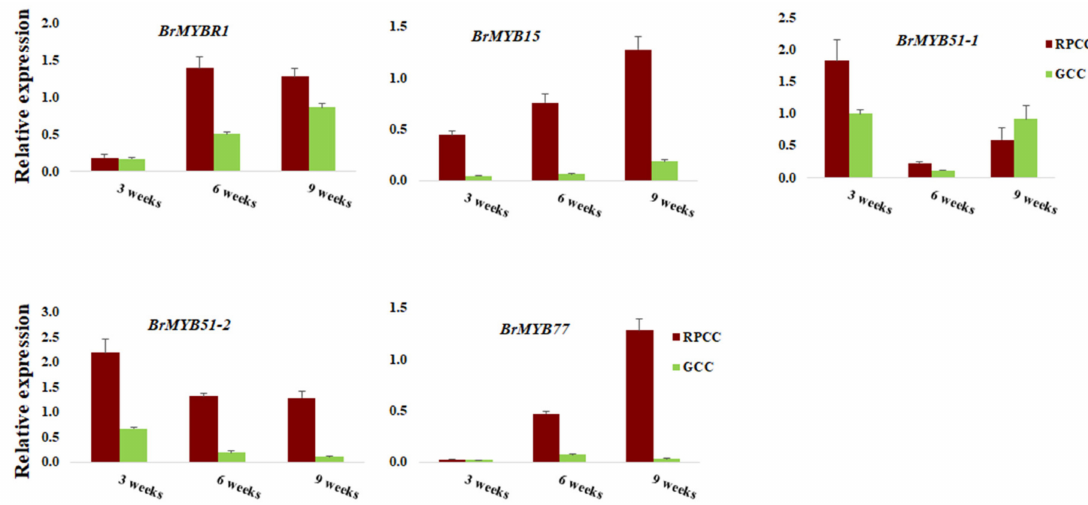
Figure 6. qRT-PCR validation of MYBs with high transcript abundance in transcriptome data. qRT-PCR expression values were normalized against that of Actin . Error bars are based on mean of three technical replicates.